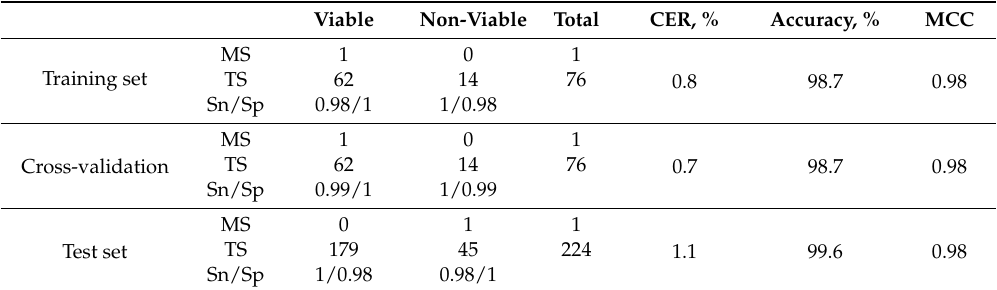
Table 3. The details of PLS-DA classification model on seed viability for training, cross-validation and error rate, MCC—Matthews correlation